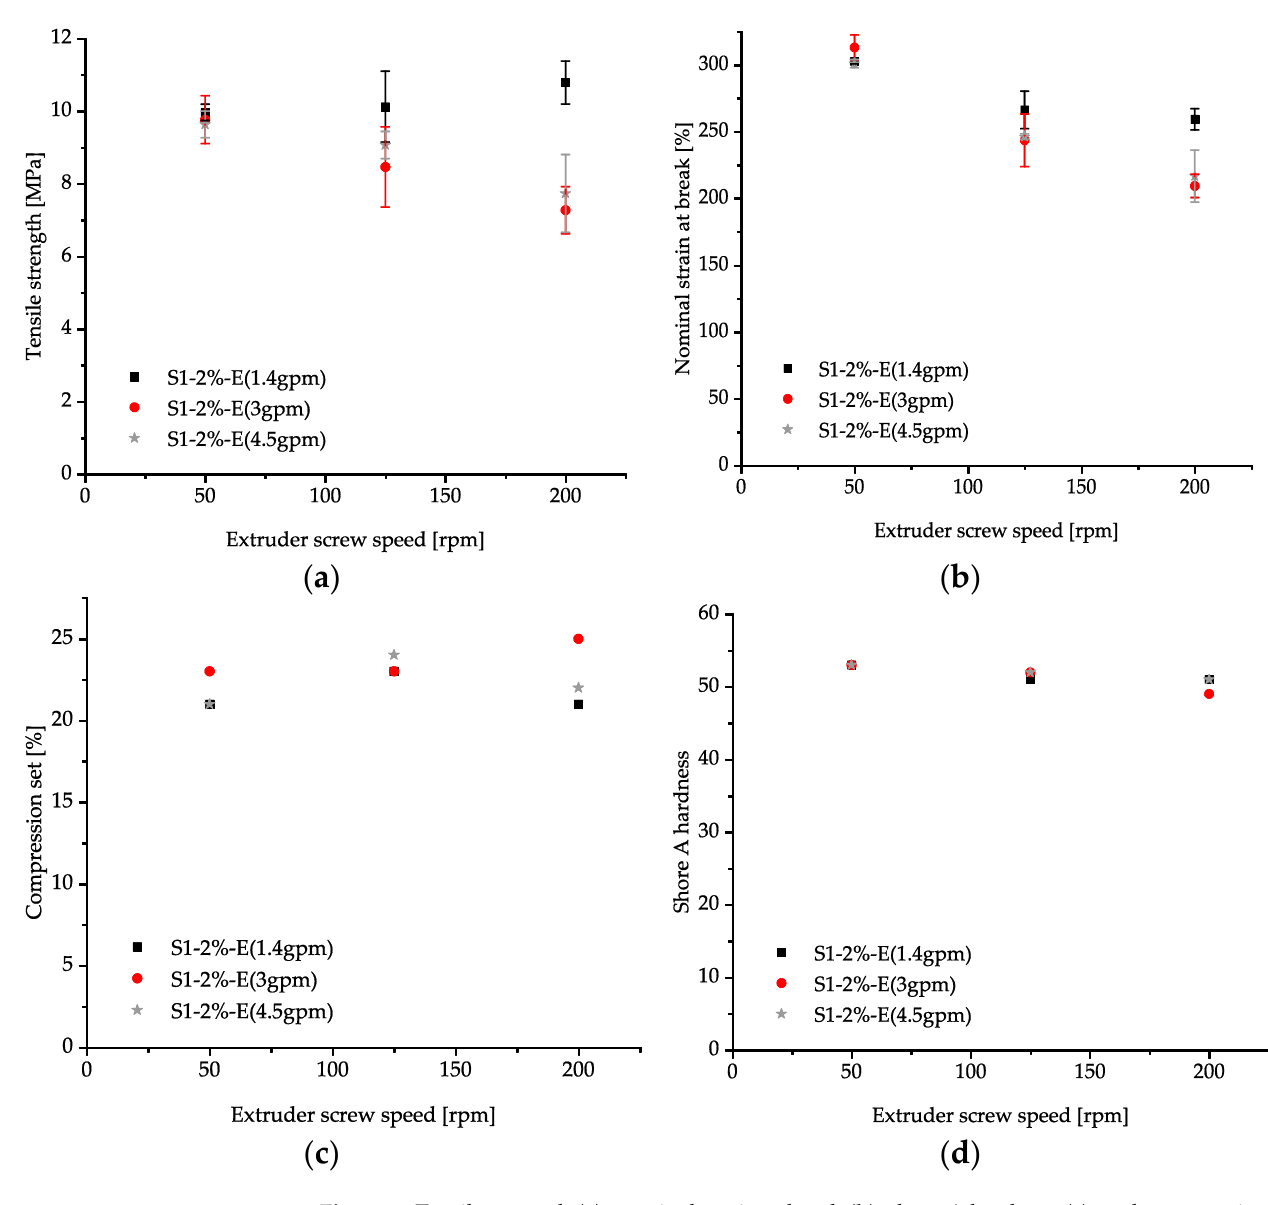
( b ) Figure 5. Torque minimum of S1-2%-E as a function of screw speed and flow rate ( a ) and rheometer curves recorded at 180 °C of S1-2%-E (3 gpm) with pictures of the ext ruded material ( b ). The mechanical properties were determined on compression-molded test sheets. The tensile strength (Figure 6a) increases at higher screw speeds for 1.4 gpm and decreases